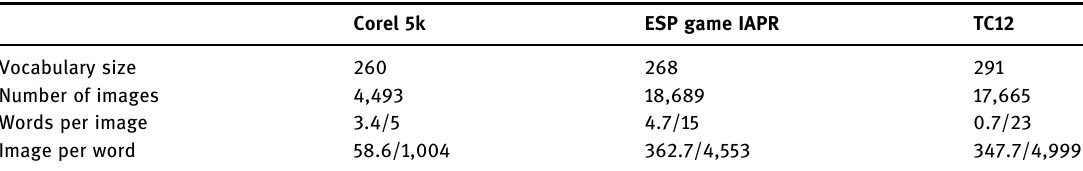
Table 1: Statistics of the training sets of the three data